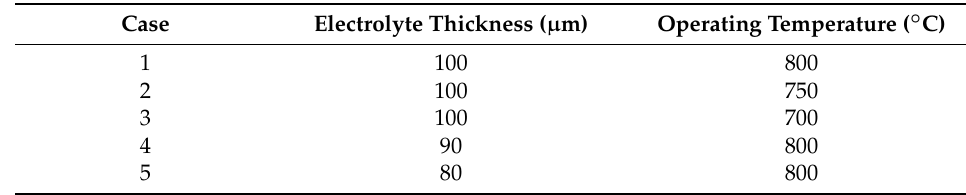
Table 7. Numerical simulation